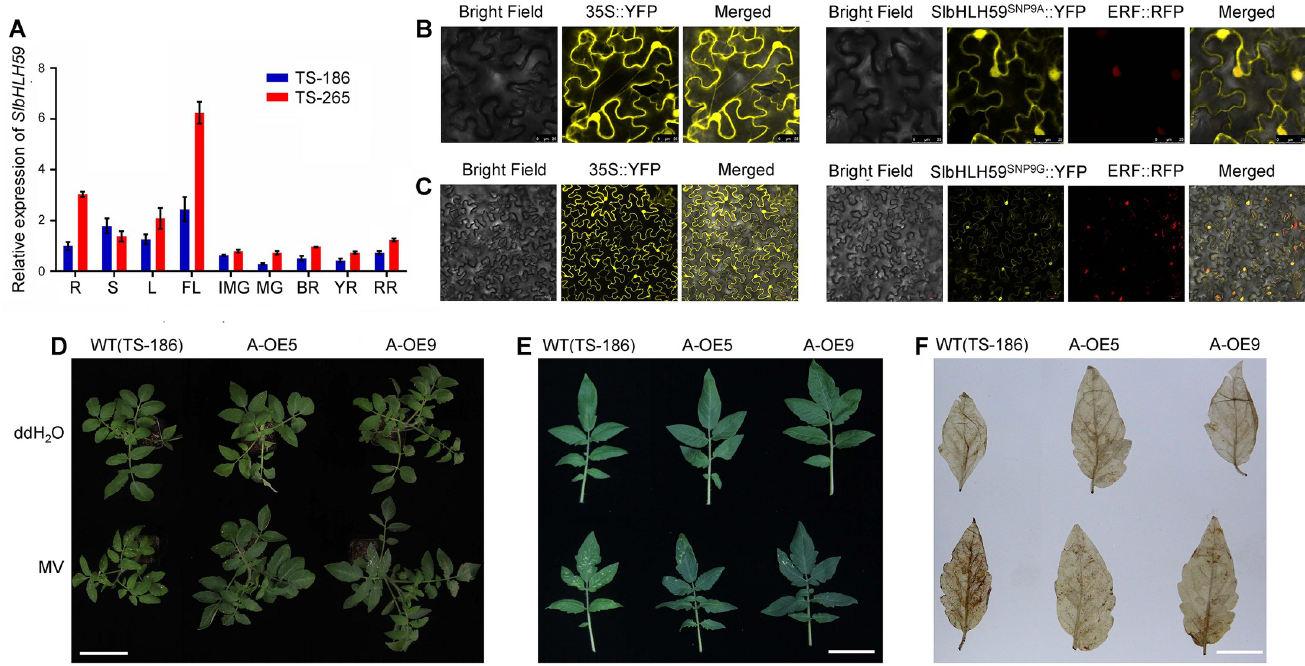
Fig 4. The characterization of SlbHLH59 . (A) The transcript levels of SlbHLH59 indifferent tomato organs: R, root; S, stem; L, leaf; FL, flower; IMG, immature fruit; MG, mature green fruit; BR, breaker stage fruit; YR, yellow stage fruit; RR, red ripe stage fruit. TS-186 is a low-AsA accession; and TS-265 is a high-AsA accession. (B, C) Subcellular co-localization of transiently expressed SlbHLH59 SNP9A -YFP (B) and SlbHLH59 SNP9G -YFP (C) fusion protein with a nuclear marker (ERF) in N . benthamiana leaves. Bars = 50 μ m. (D-F) Phenotype comparisons of SlbHLH59 -OE and wild-type plants after methyl viologen (MV) treatment. The SlbHLH59 -OE transgenic plants had less yellow lesion (D, E) and H 2 O 2 accumulation (F) than WT after MV treatment. Bar = 10 cm (D) , 5cm (E) and 2cm (F) .